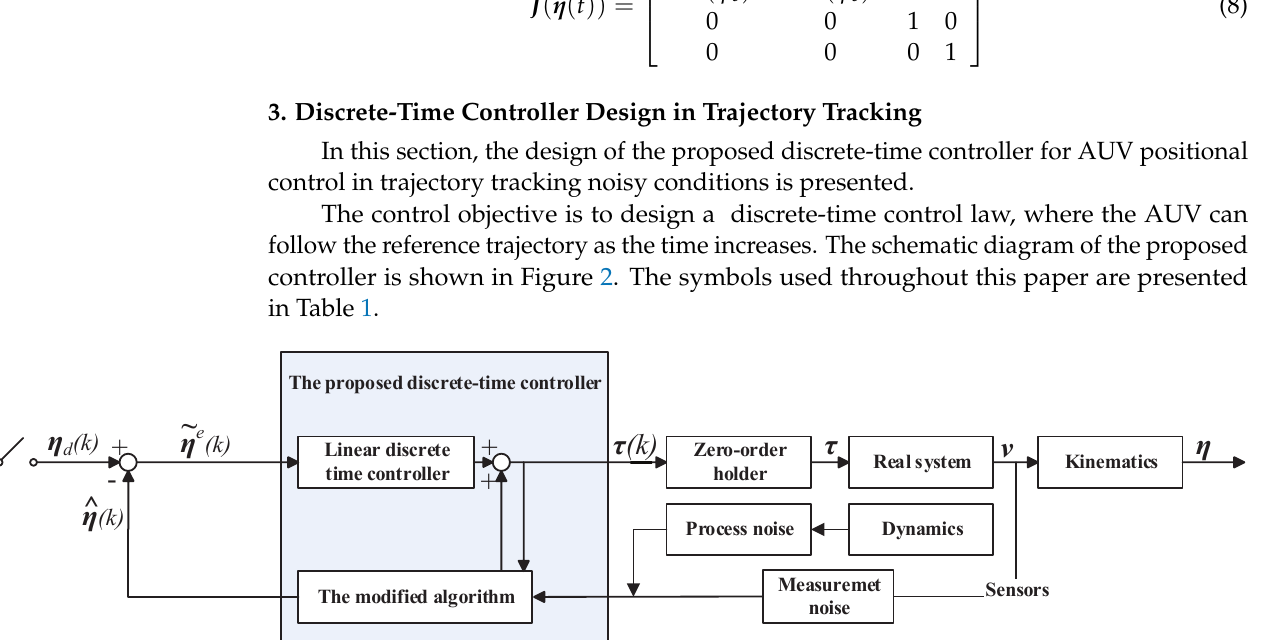
Figure 2. Schematic diagram of the proposed discrete-time position control for trajectory